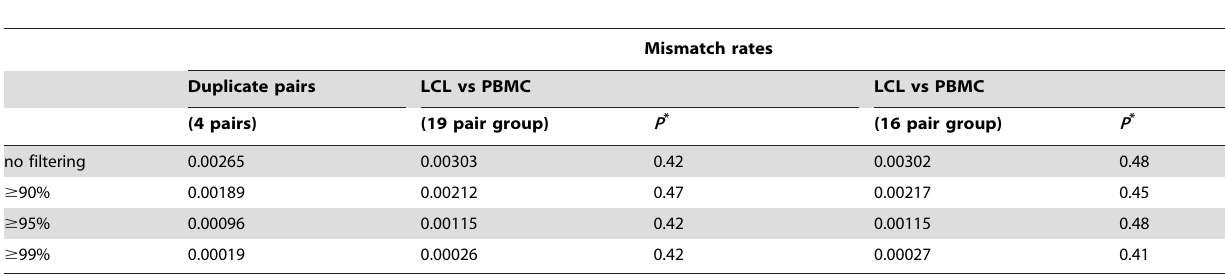
Table 2. Comparisons of mean SNP mismatch rates seen in LCL and PBMC pairs to rates seen in control (sample duplicate) pairs, at different levels of filtering by population call